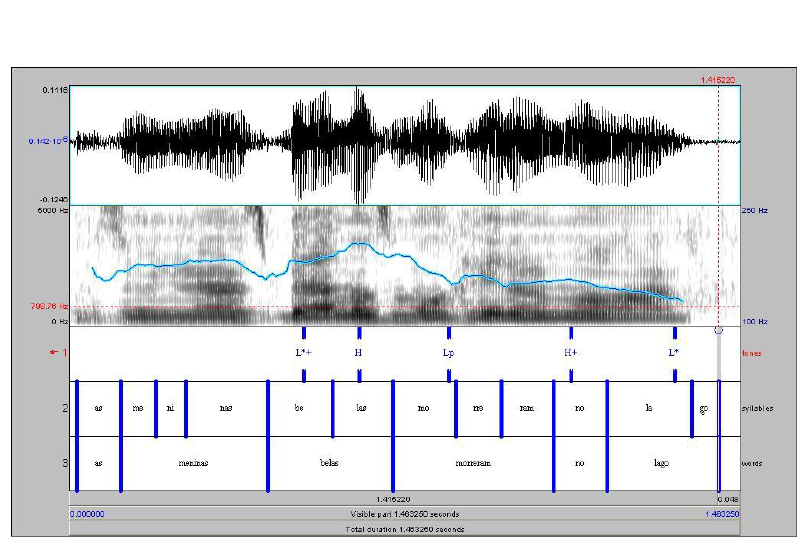
Figure 6. F 0 contour of the subject-focus sentence As meninas belas morreram no lago ‘The beautiful girls died in the lake’ produced by F in the context of narrow-focus on the